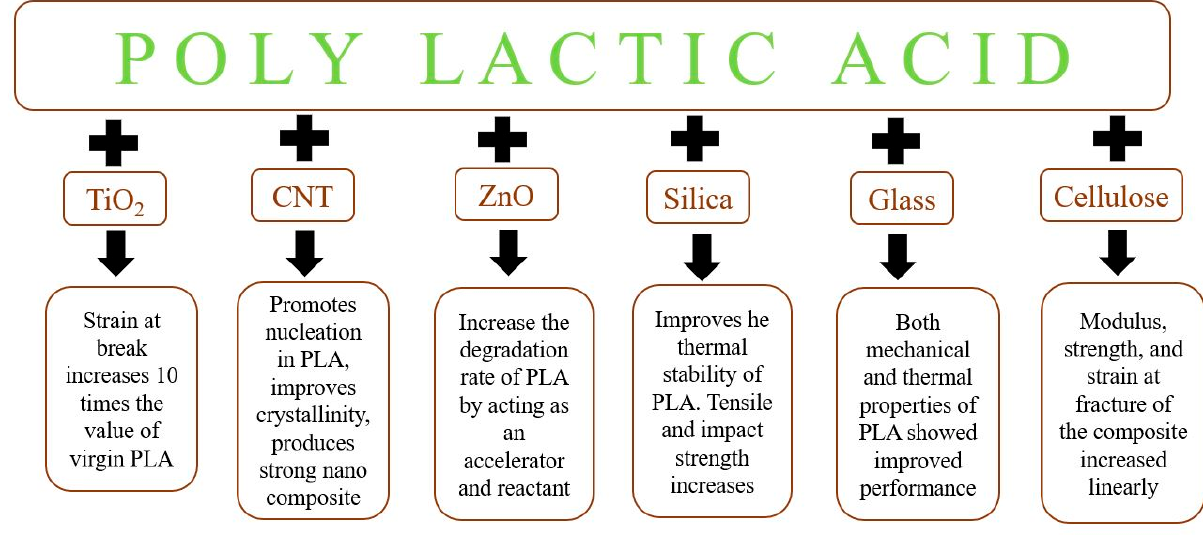
Figure 10. Summarized effect of some typical nanofiller on the properties of PLA.